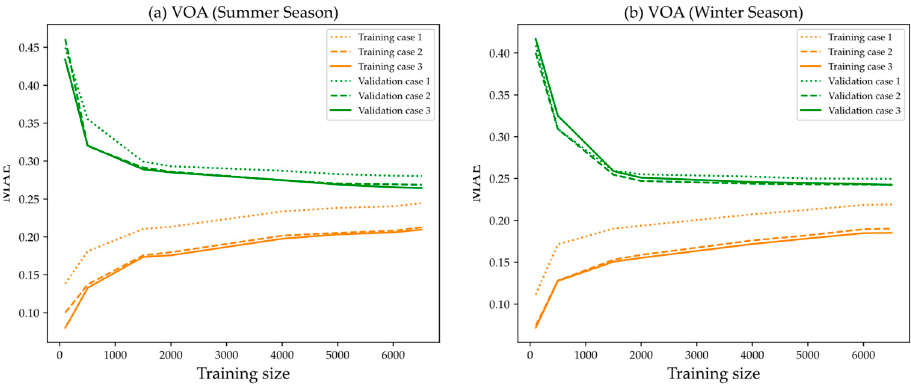
Figure 7. Learning Curves for VOA. ( a ) Summer season. ( b ) Winter season.